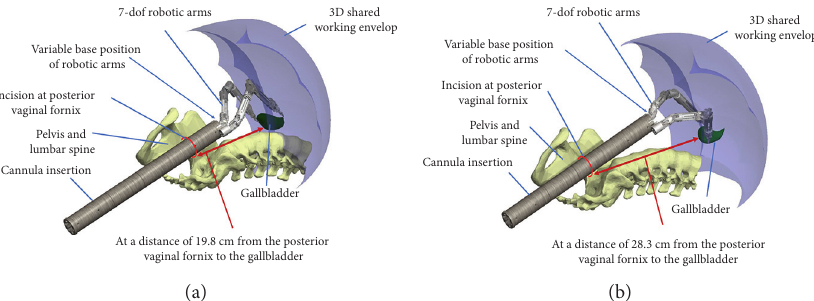
Figure 9: Workspace overlap and reachability with gallbladder at (a) 19.8cm while maintaining end-effector dexterity and (b) 28.3cm where dexterity is